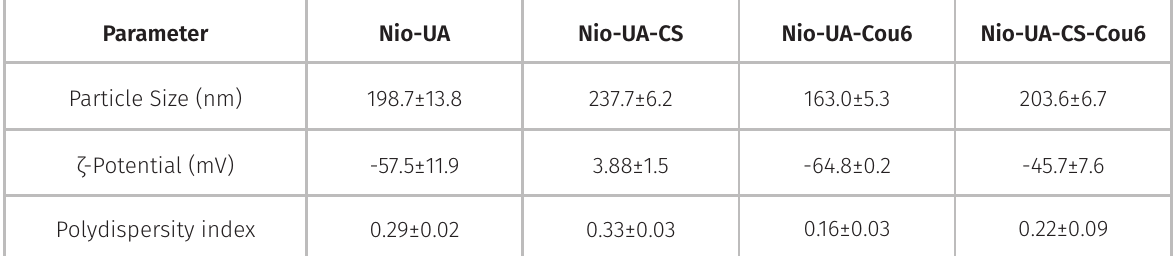
Table I. Physical characteristics of Nio-UA, Nio-UA-CS, Nio-UA-Cou6, and Nio-UA-CS-Cou6.